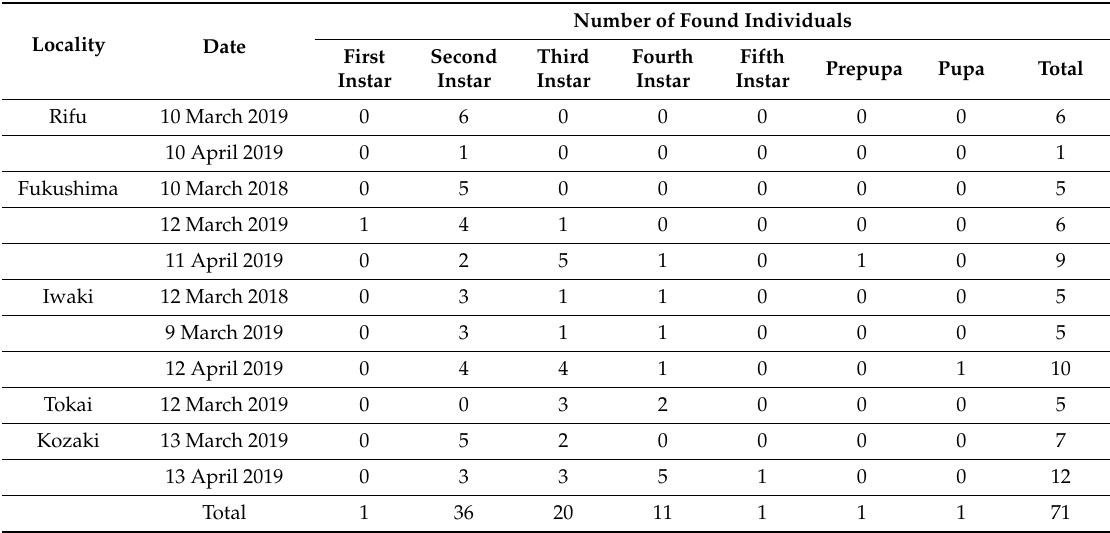
Table 1. Localities of field work and the number of individuals found in situ.